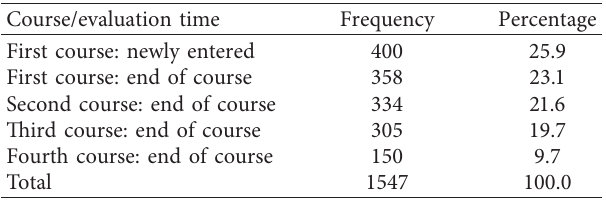
Table 1: Descriptive analysis of the course in which the participants were enrolled and time of